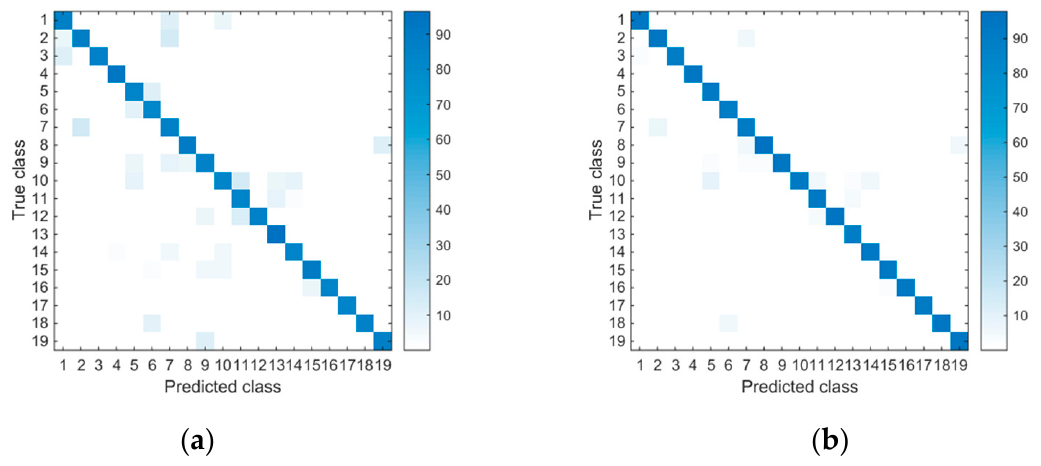
Figure 8. Confusion matrices for the ensemble all approach ( a ) and the proposed IBGSO-based ensemble approach ( b ) using the DSA.